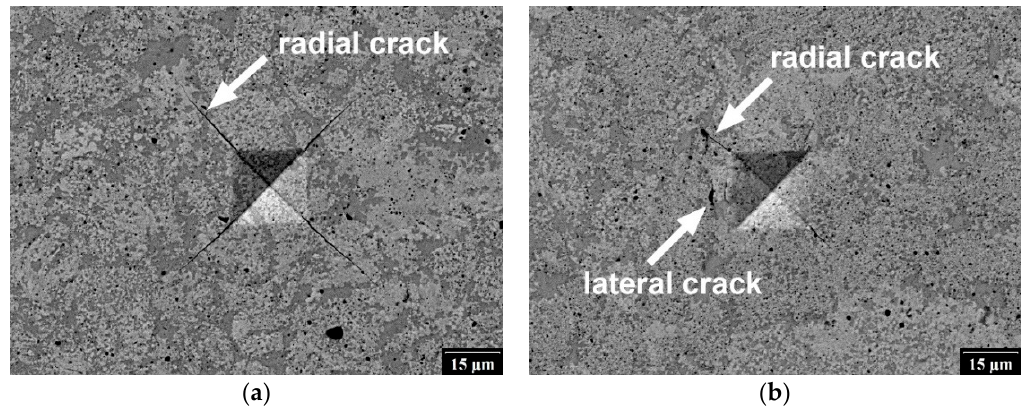
Figure 11. Cracks propagating from the Vickers indentation: ( a ) Fe_Al_Si, ( b ) FeAl_Si.